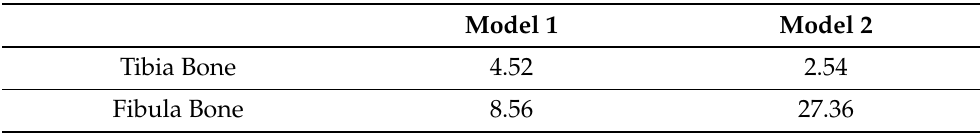
Figure 12. Line plot of the real part relative permittivity mean value of extracted bones under additional BVF scenarios for model 1 (red lines) and model 2 (blue lines). The black line represents the actual values of the real part relative permittivity. Table 2. A comparison of the root mean square error (RMSE) values between the actual real-part permittivity values and the extracted values from the reconstructed images for different BVF